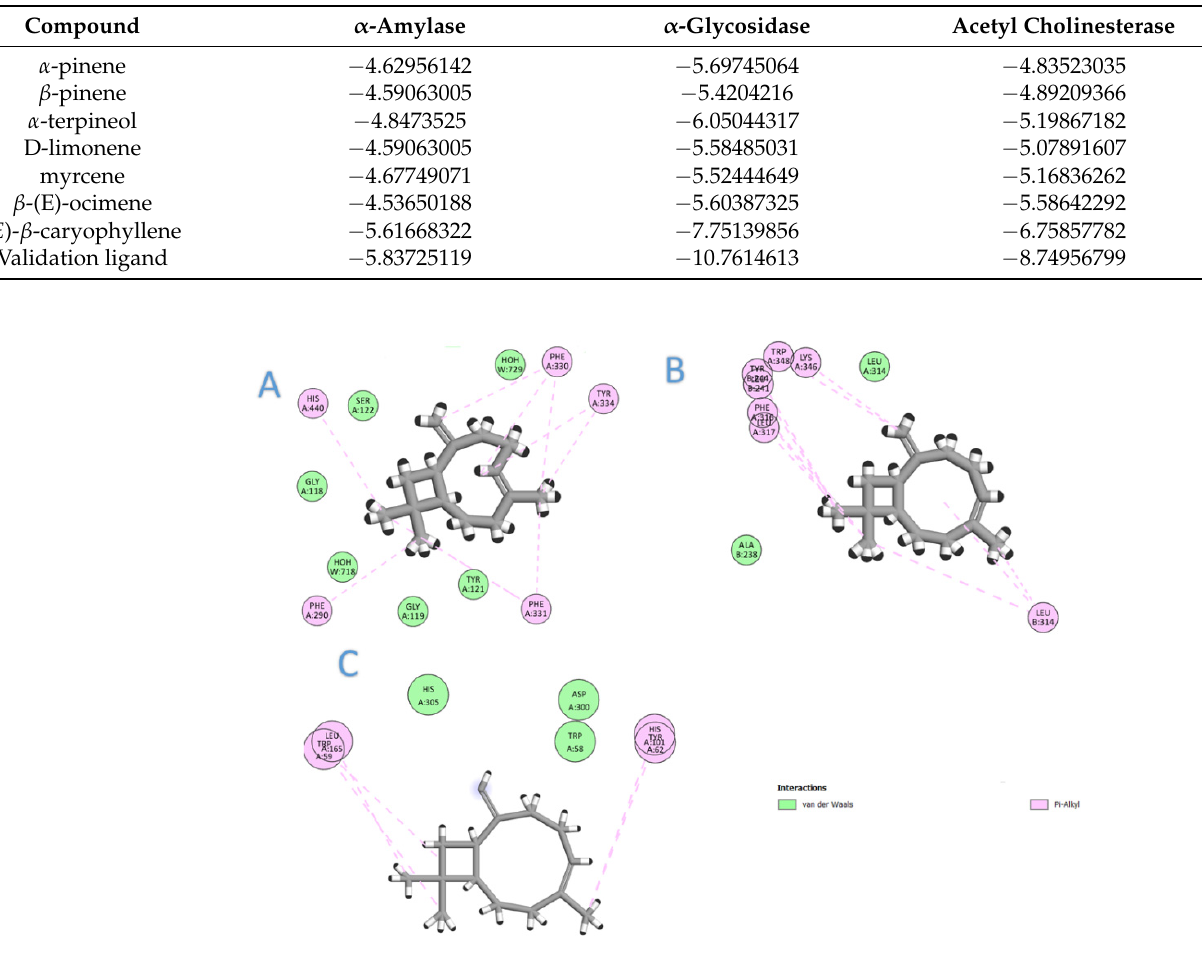
Figure 2. The 2D interaction diagram of ( E )- β -caryophyllene with the three targets: ( A ) acetylcholinesterase; ( B ) α -glucosidase; ( C ) α -amylase.